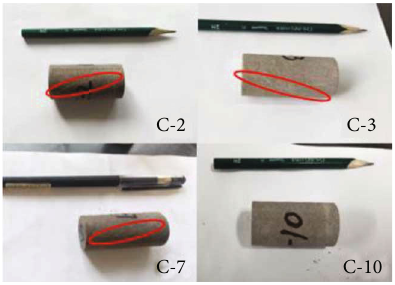
Figure 5: Fractured cores and unfractured